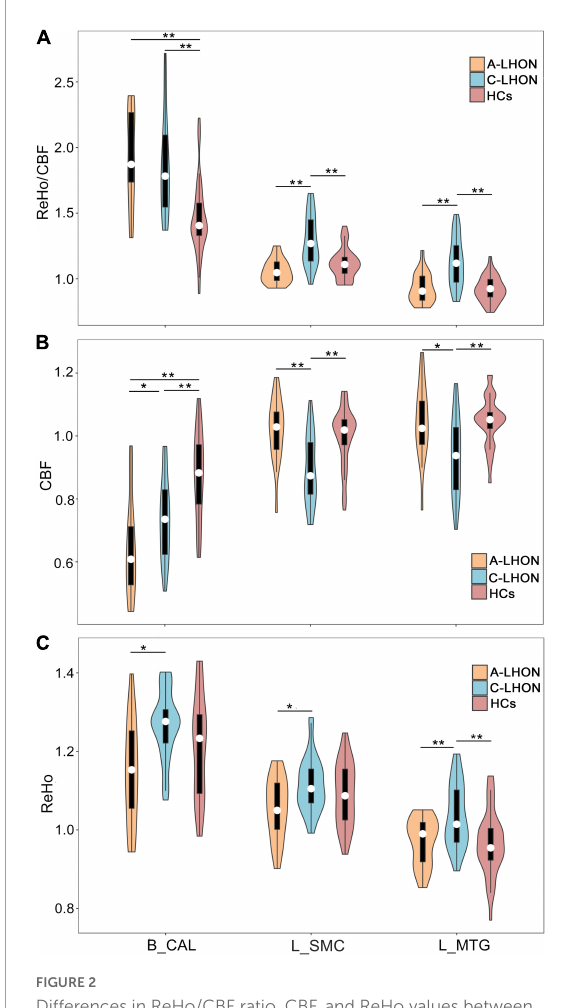
FIGURE2 Differences in ReHo/CBF ratio, CBF, and ReHo values between each pair of groups. *Survival under a nominal p < 0.05, **survival under a Bonferroni-corrected p < 0.05 (equal normal p < 1.85e - 3 ). CBF, cerebral blood flow; ReHo,